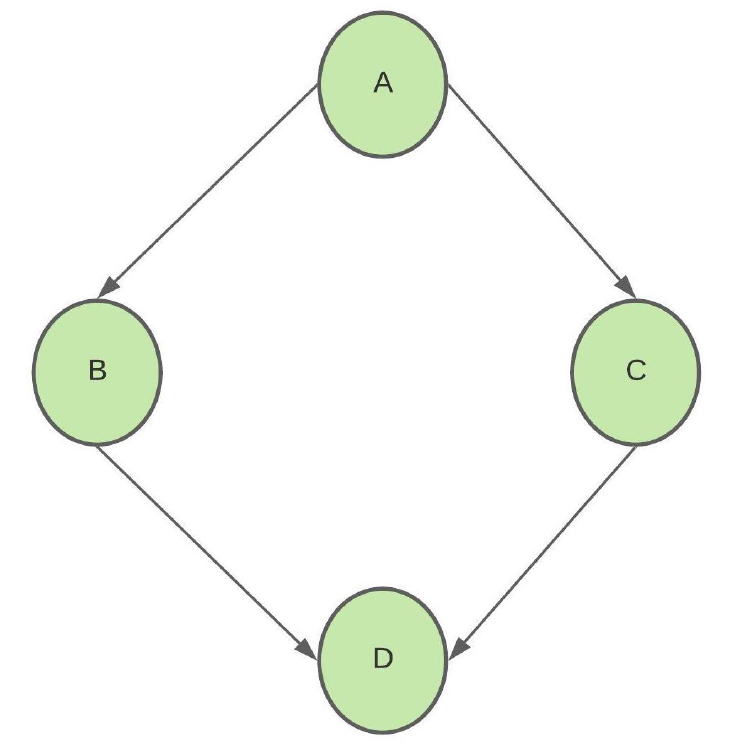
Figure 4. Example BN with binary